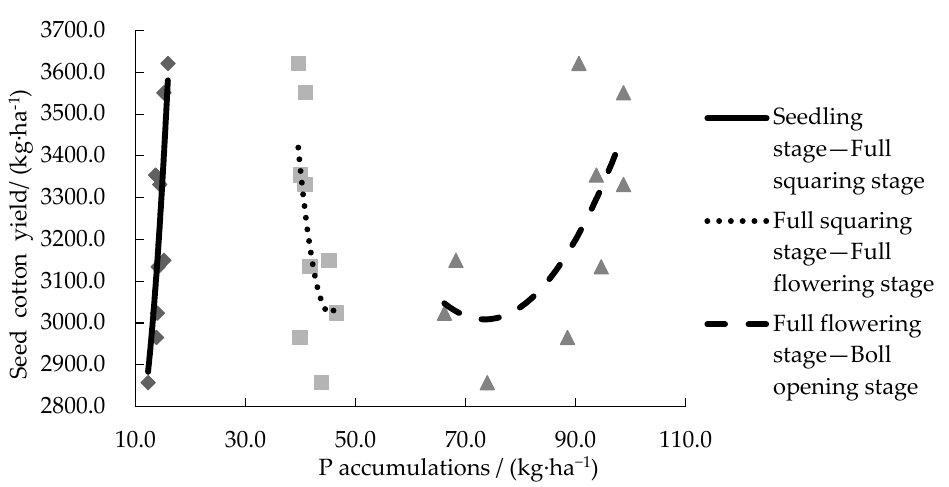
Table 5. Effects of density and Miantaijin on K accumulations (2018).